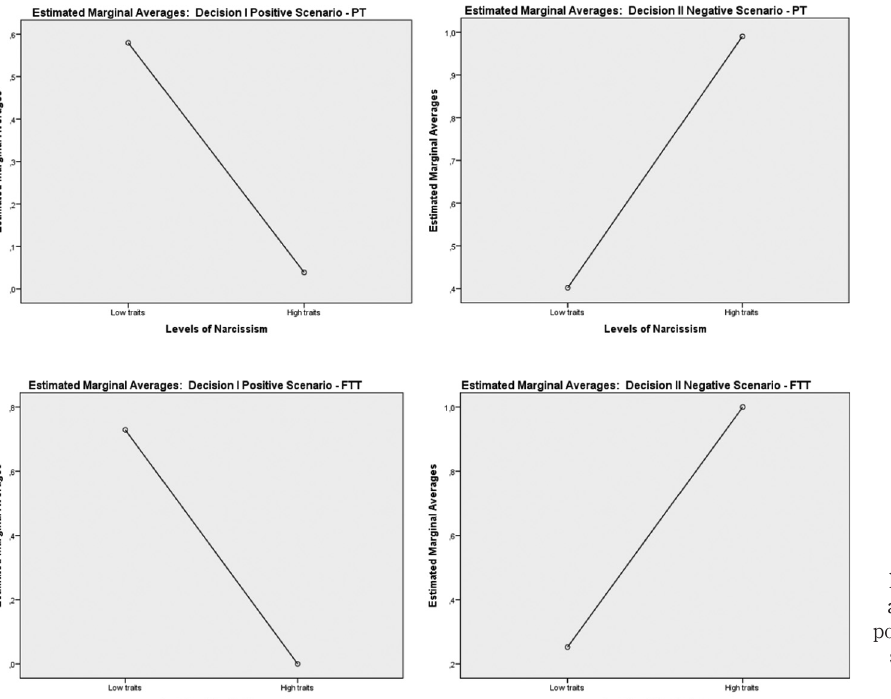
Figure 2. Graph of the marginal means estimated for the levels of narcissism and decisions in the positive and negative scenarios in the DT and